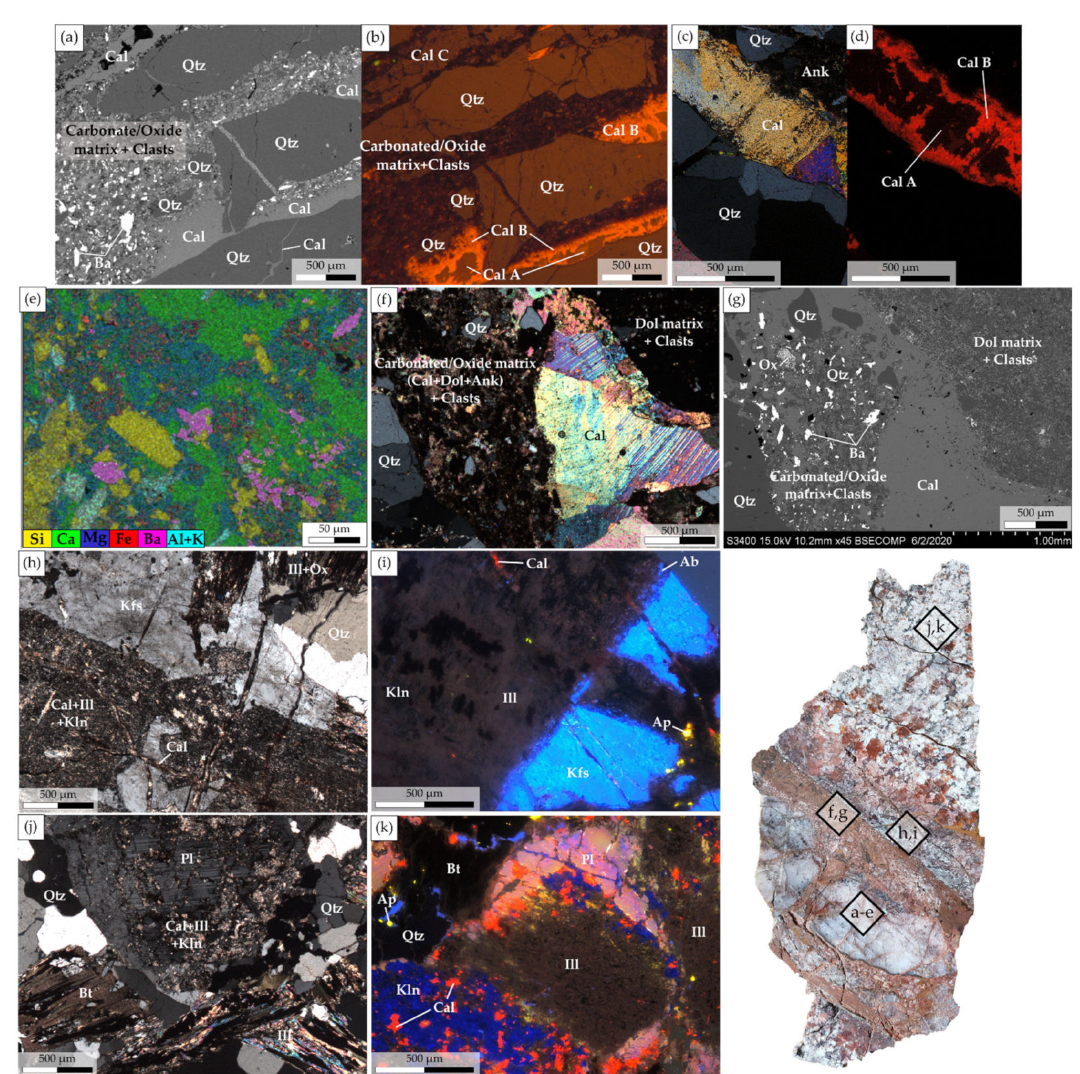
Figure 9. Photomicrographs of the different compartments of the sample NH_31 and their locations in the sample. ( a , b ) Respectively back-scattered image and CL images of calcite veins composed of two phases (Cal A and Cal B) cross- cutting quartz, crosscut by a phase made of a carbonate/oxide matrix (calcite, dolomite, ankerite) with barium patches and transported clasts of quartz, K-feldspars, and few biotites, crosscut by later calcite veins (Cal C). ( c , d ) Zoom on the first generation of calcite vein and crosscutting quartz under optical microscope in polarized–analyzed light and showing two phases under CL. ( e ) A chemical quantification map realized under SEM of the carbonate/oxide matrix with barium and clasts. Different colors show a relative abundance of specific chemical elements (counts). ( f , g ) A photomicrograph under optical microscope in polarized–analyzed and under SEM, respectively, of the contact with the granite showing a dolomite matrix with transported clasts intersected by a calcite vein, the whole intersected by a carbonate/oxide matrix with transported clasts and barium precipitation patches. ( h ) The altered granite close to the brecciated vein showing a completely altered plagioclase replaced by calcite, kaolinite, and illite, a completely altered biotite replaced by illite and oxides and non–altered K-feldspar and quartz under an optical microscope in polarized–analyzed light. ( i ) The altered granite close to the brecciated vein presented in ( h ) under CL showing illite with no luminescence, in light blue an unaltered K-feldspar, in red some calcite and apatite in yellow. ( j ) The altered granite, away from the brecciated vein, showing a plagioclase partially replaced by calcite, kaolinite, and illite, biotites partially replaced by illite, and oxides, and unaltered quartz under optical microscope in polarized–analyzed light. ( k ) The altered granite away from the brecciated vein presented in ( j ) under CL showing kaolinite in dark blue, calcite in red, apatite in yellow and illite, quartz and biotite with no